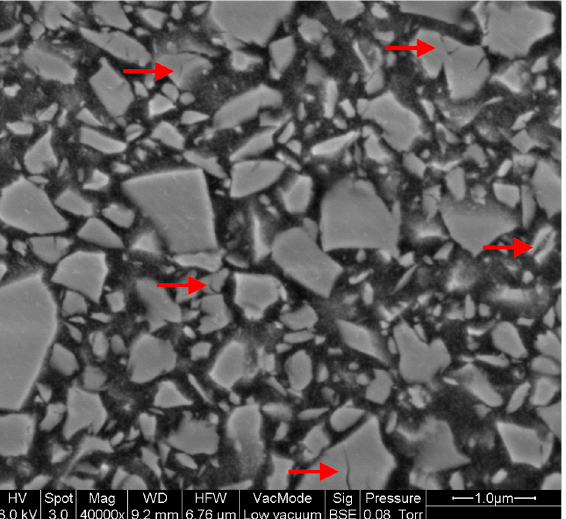
Figure 8. Example for microcracks (red arrows) observed in the filler particles in BRILLIANT Crios (CBC_A2HT).